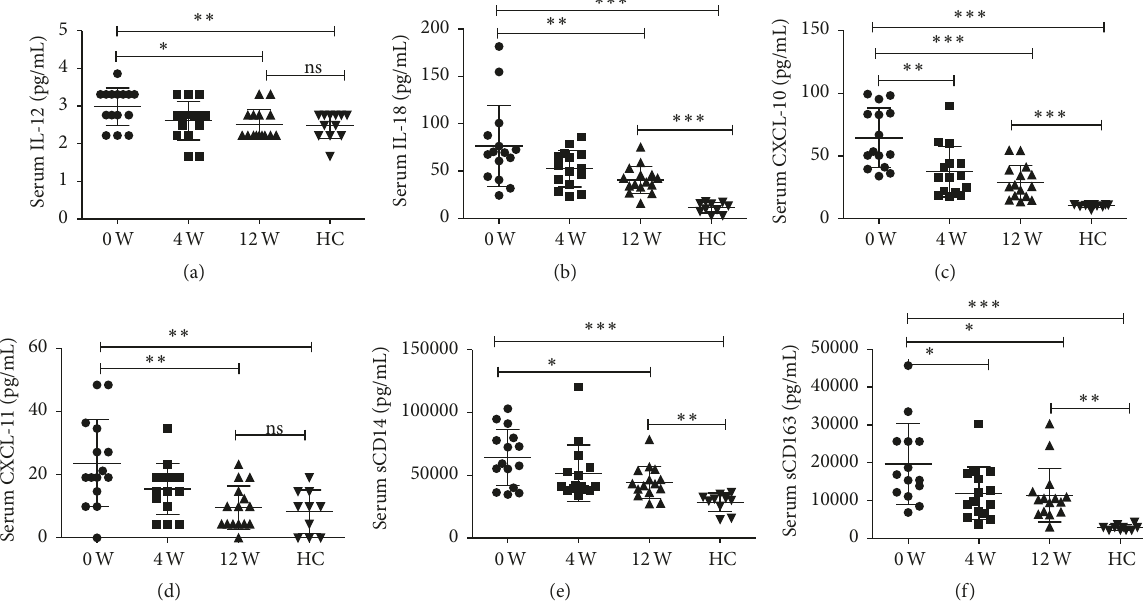
Figure 2: Kinetics of the levels of serum cytokines during DAAs treatment . (a) Dynamic changes of the levels of IL-12; (b) dynamic changes of the levels of IL-18; (c) dynamic changes of the levels of CXCL10; (d) dynamic changes of the levels of CXCL11; (e) dynamic changes of the levels of sCD14; (f) dynamic changes of the levels of sCD163. ∗ 𝑝 < 0.05 ; ∗∗ 𝑝 < 0.01 ; ∗∗∗ 𝑝 < 0.001 .